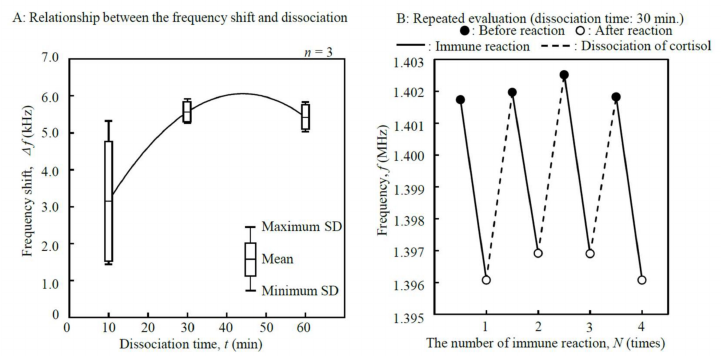
Figure 10. Results of repeated evaluation when immunoreaction and dissociation were performed using one disk-shaped resonator (1.402 MHz measured frequency).